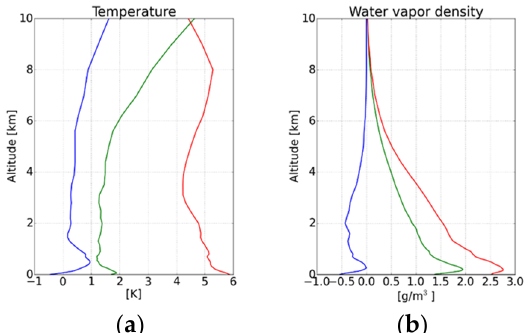
Figure 2. The results of the comparison of microwave and radiosonde data measured in May–August of 2014–2018: ( a ) temperature; ( b ) water vapor density. Blue and green lines show mean difference (radiosonde minus microwave) and standard deviation of temperature and water vapor density, correspondingly. Red lines indicate the natural variability of temperature and water vapor density.